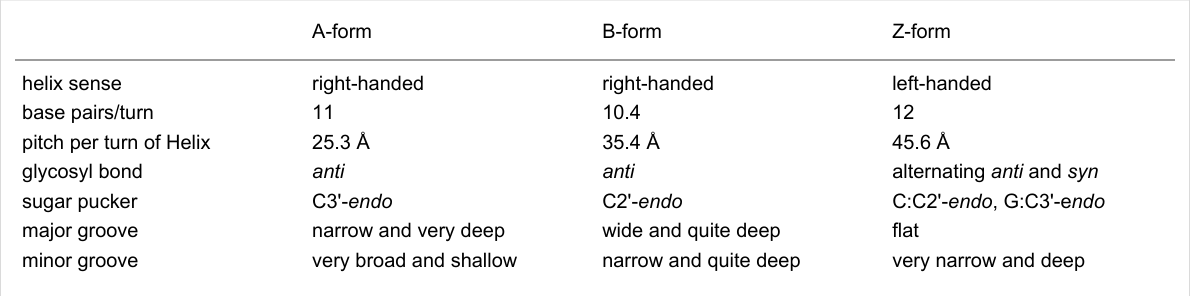
Table 1: A table showing the differences in the A-, B- and Z-form DNA